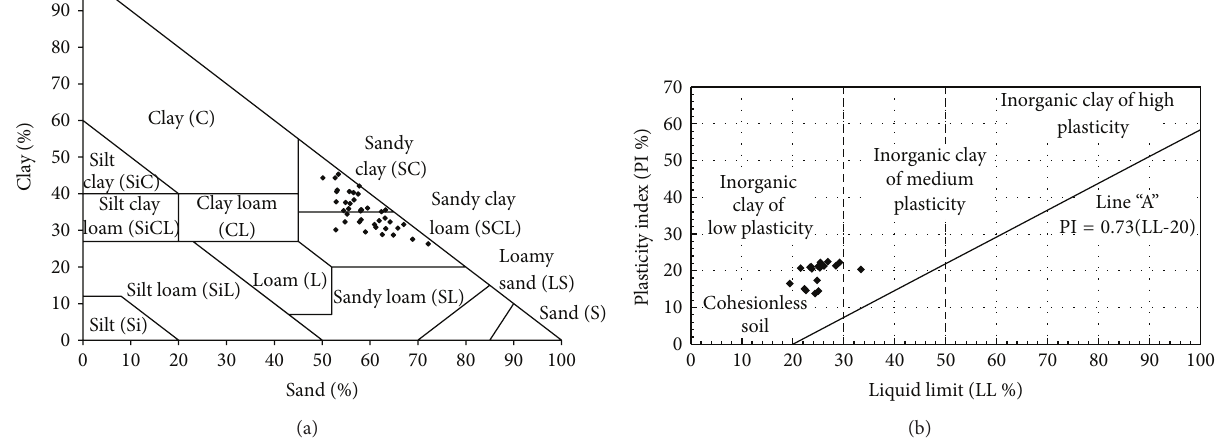
Figure 3: Dispersion of range samples into texture triangle (a) and limits consistency (b).